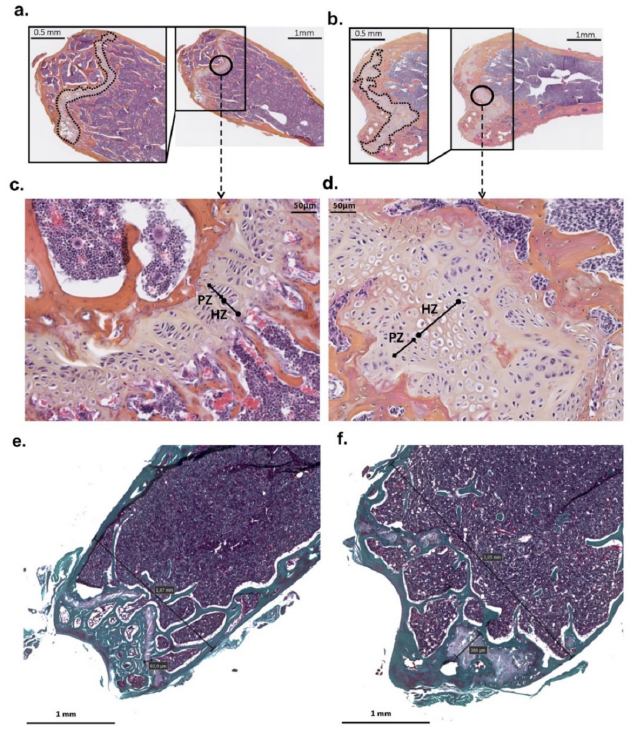
Figure 2. Distal femur histology of Phex L222P and WT mice. The cross-section of the distal femur of mutant male ( Phex L222P /Y) ( b , d , f ) compared to littermate ( Phex /Y) control ( a , c , e ) at 3 months of age. The growth plate is outlined in the magnifications of the boxed area. c and d are a magnification of the circled area in ( a , b ), respectively. ( e , f ) represent trichrome stains. Scale bars are presented on the figure. PZ: proliferative zone, HZ: hypertrophic